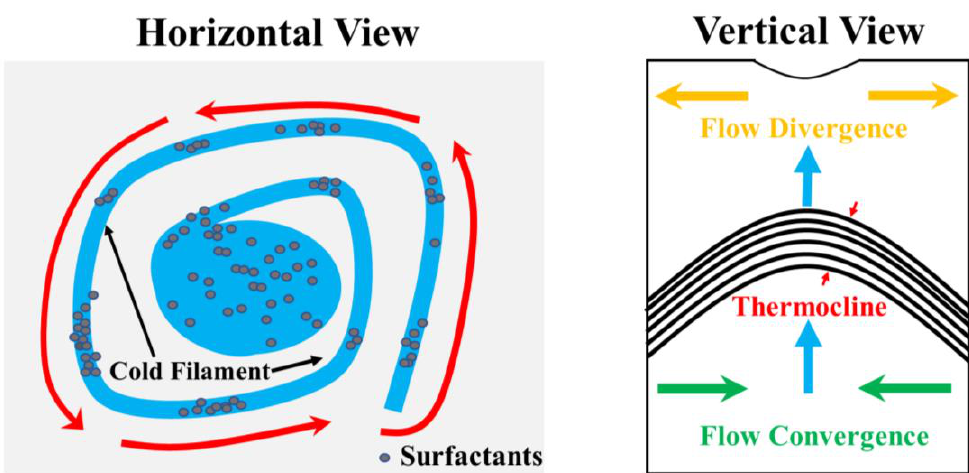
Figure 2. Left panel: sketch of a cyclonic gyre (counterclockwise rotating; red arrows). Right panel: the associated upwelling of the thermocline in the center of the gyre (blue arrows).